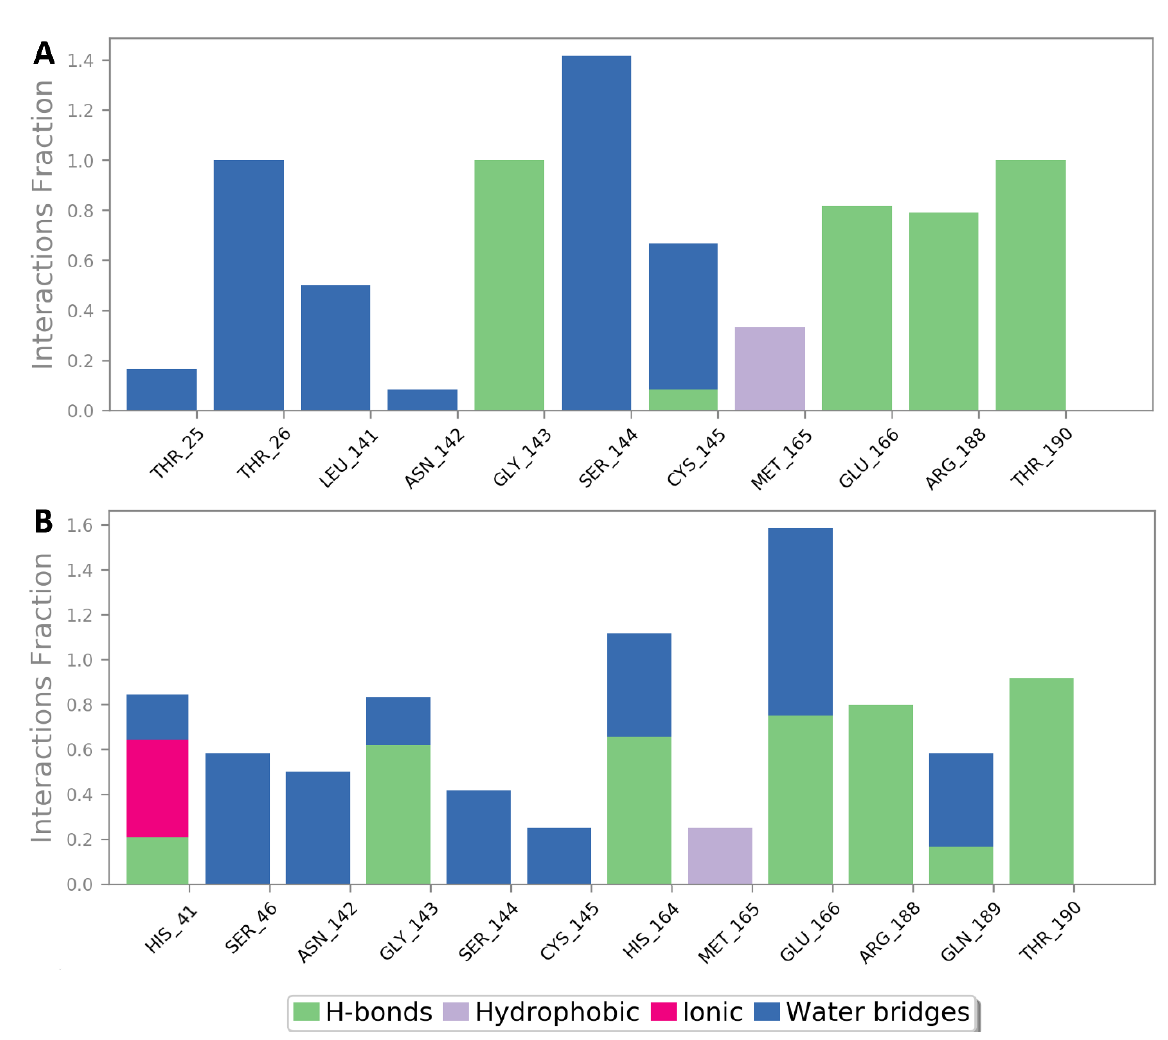
Figure 4. Protein – ligand interactions of both cefepime and ceftazidime ( A , B , respectively) during the course of MDS.